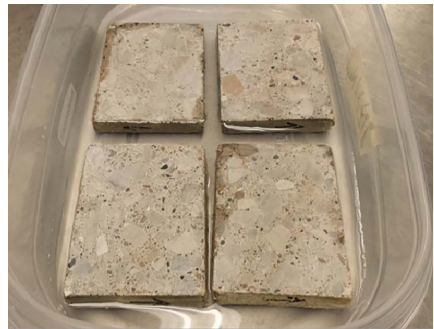
Figure 7: Samples partially immersed in